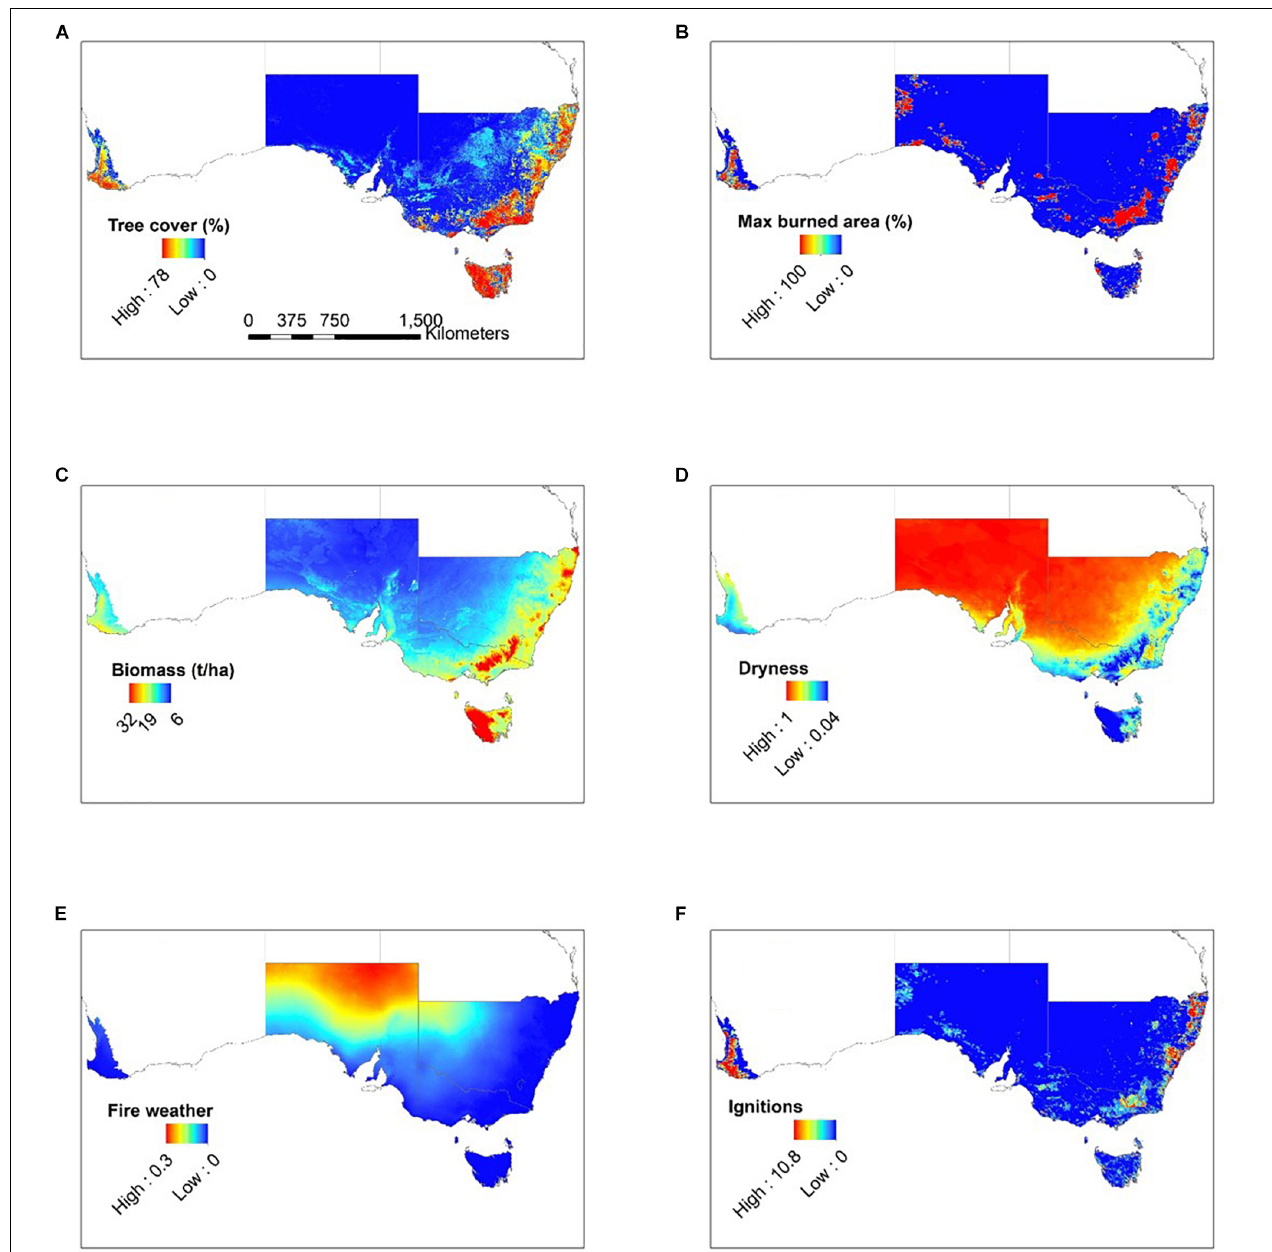
FIGURE 1 | Study area, response variable and predictors. Study area (A) comprises southern Australian states and territories including southwest Western Australia. Response variable (B) is areas with a maximum burned area greater than 50% (1,250 ha). Predictors are biomass (C) , dryness (D) , fire weather (E) , and ignitions (F) . Predictor units are: (C) steady state litter or grass biomass in t ha − 1 ; (D) proportion of the fire season where PET > precipitation; (E) proportion of the fire season where FFDI > 50; (F) number of ignitions per fire